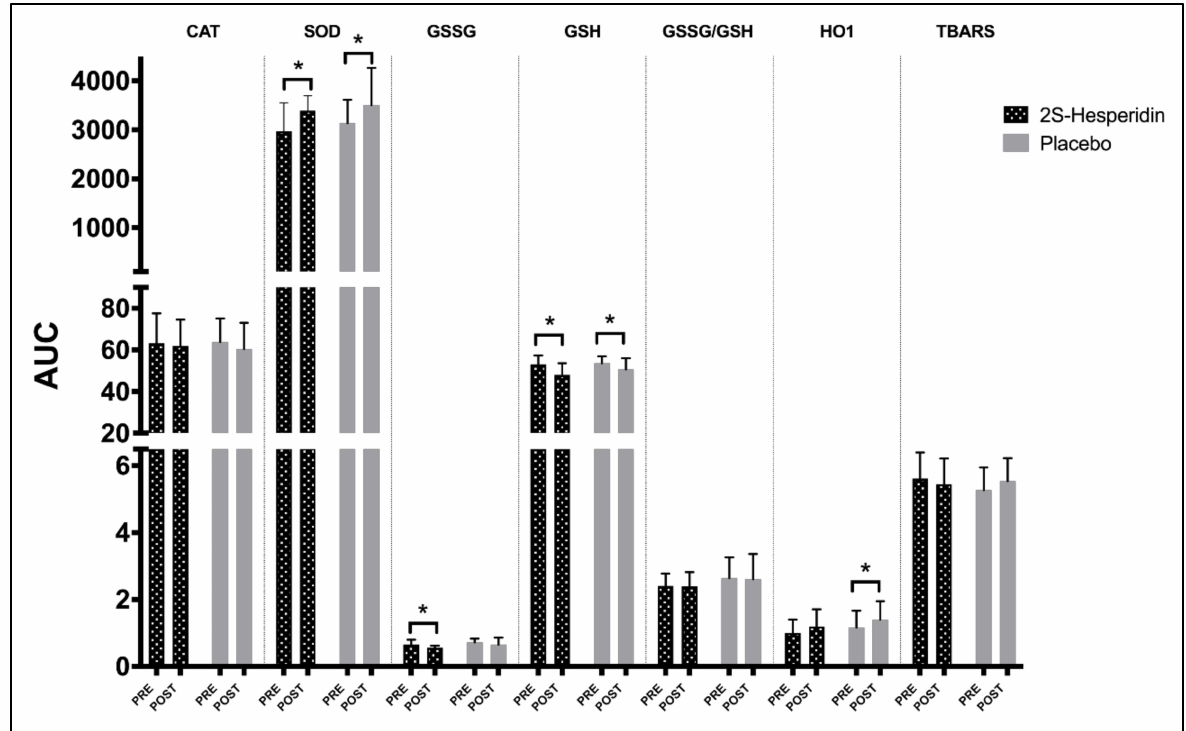
Figure 3. Intragroup differences between AUC (pre- and post-intervention) in antioxidant parameters. * p < 0.05. There were no significant differences between groups in